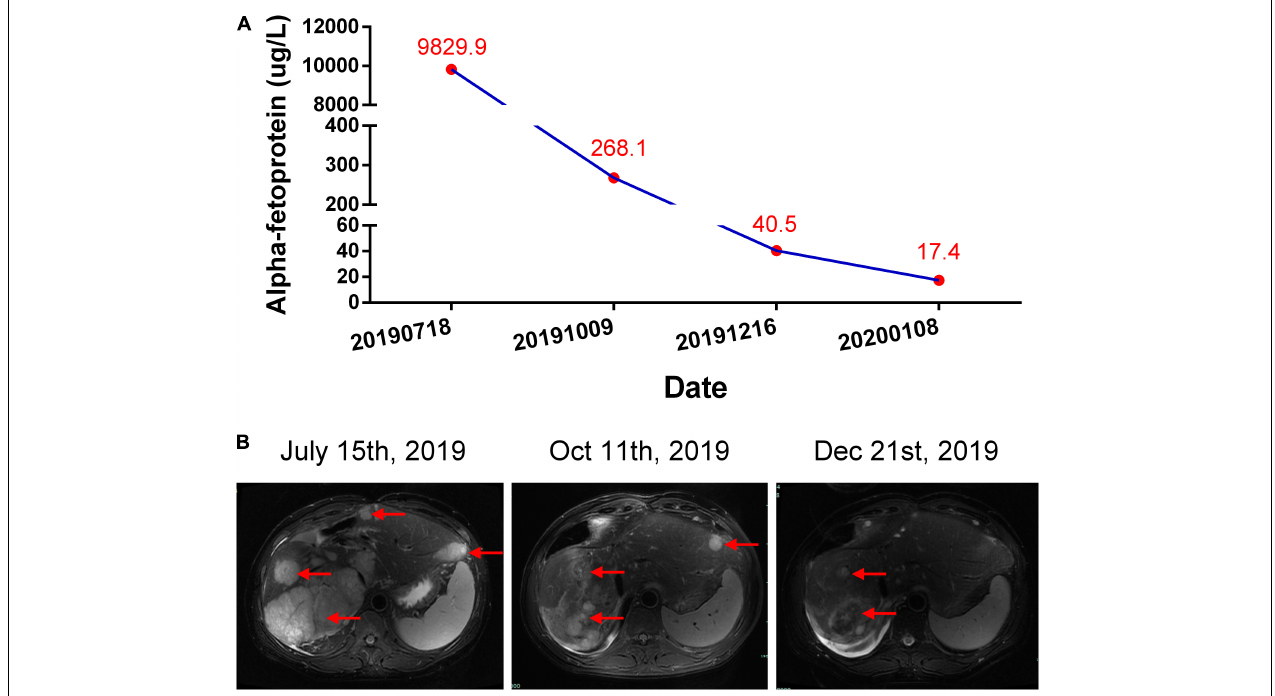
FIGURE 1 | Courses of the patient’s treatments. (A) Changes of alpha-fetoprotein (AFP) level during each period. (B) Representative hepatic magnetic resonance (T2 weighted) assessments during each period. Red arrows indicate the